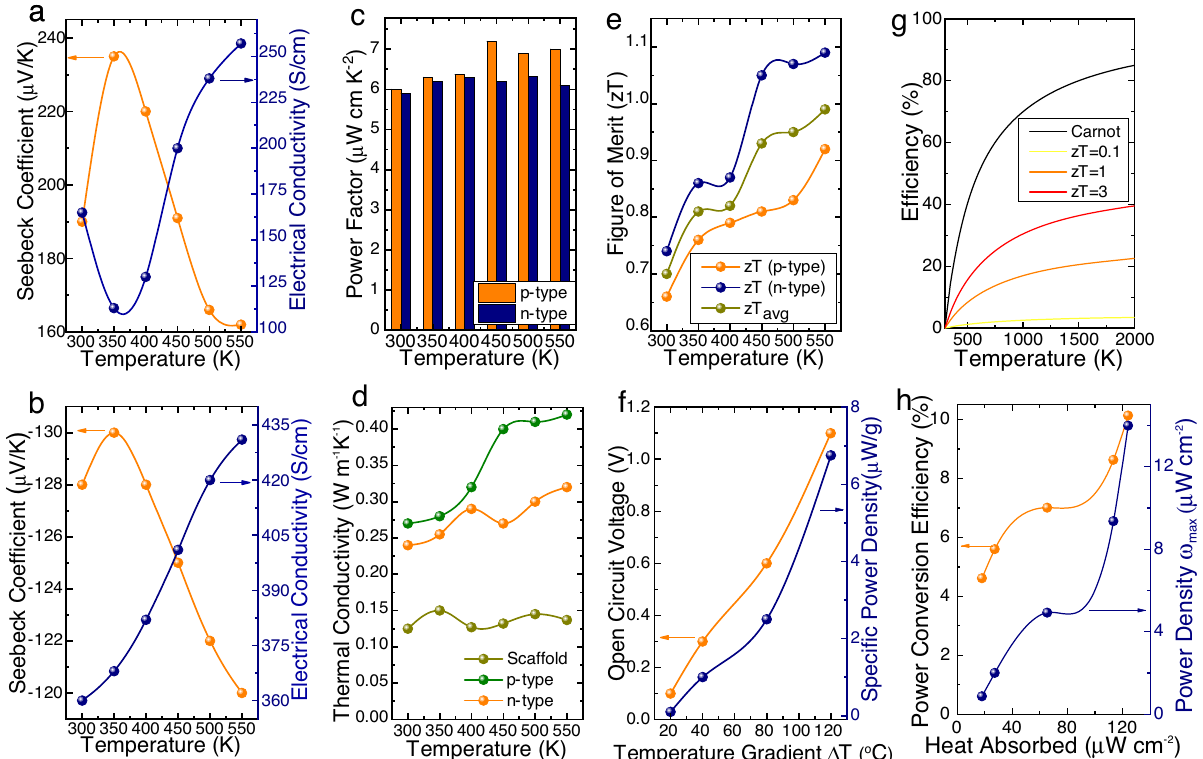
Fig. 2 | Thermoelectric properties of the architected TEGs. a , b Seebeck coef fi - cient and electrical conductivity of the 3D p-Sb 2 Te 3 and n-Bi 2 Te 3 legs with respect to operating temperature. c Power factor of the 3D architected p-Sb 2 Te 3 and n-Bi 2 Te 3 thermoelectric legs with temperature. d Temperature-dependent thermal conductivity of p- and n-type thin fi lms and the amorphous carbon core with respect to temperature. e Figure of merit (zT) p-Sb 2 Te 3 , n-Bi 2 Te 3 legs at different